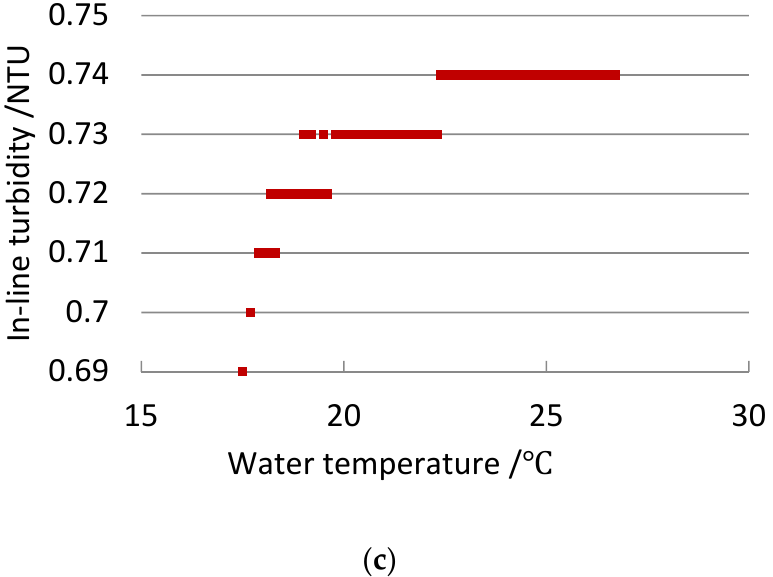
Figure 2. Scatterplot graphs for the in-line turbidity and water temperature original data set at room temperature. ( a ) Water velocity is set as 0.33 m/s. ( b ) Water velocity is set as 0.66 m/s. ( c ) Water velocity is set as 1.66 m/s.